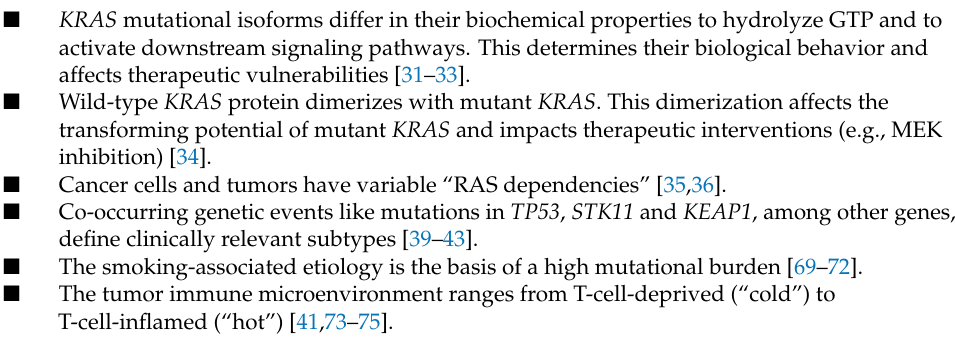
Table 1. Factors contributing to the disease heterogeneity of KRAS -mutant non-small-cell lung cancer